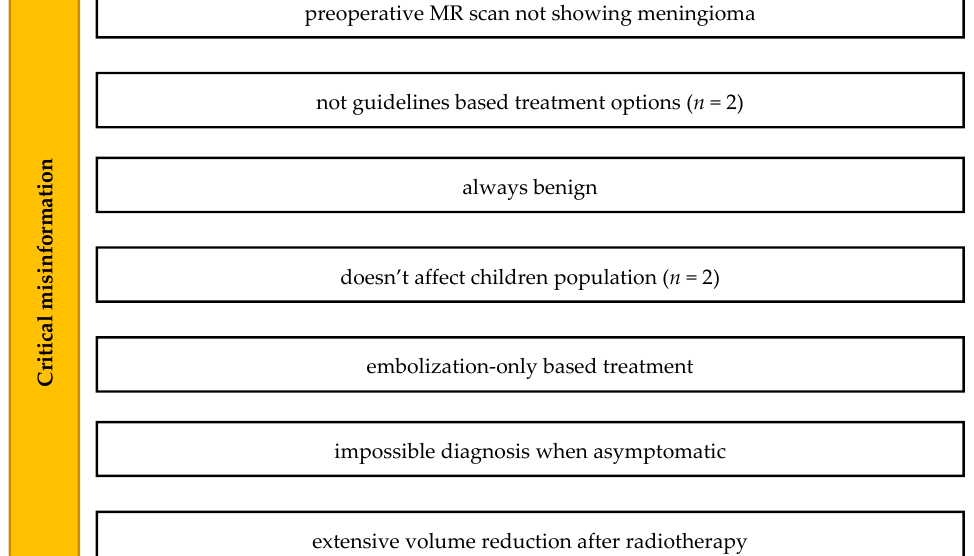
Figure 6. Critical misinformation in meningioma videos.